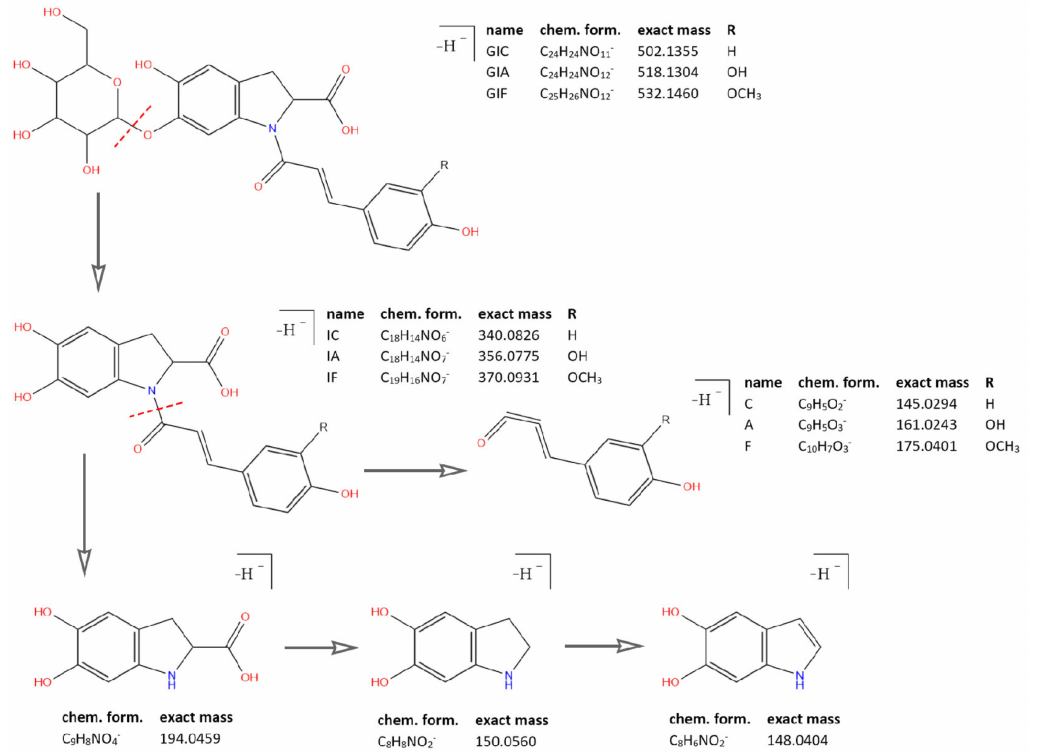
Figure 3. Common fragment ions of the three common substructures in oleraceins: GIC, GIA, and